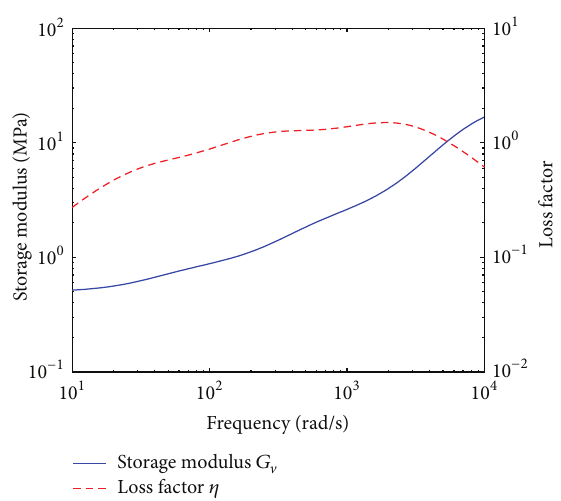
Figure 4: Frequency dependent properties of 3M ISD112 at 0 ∘